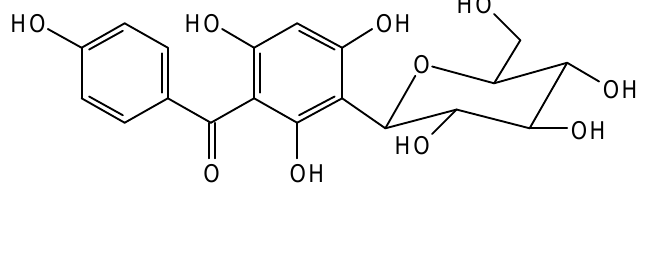
Figure 3 . Structure of Mi2, benzophenone C -glycoside, isolated from M. indica leaves.